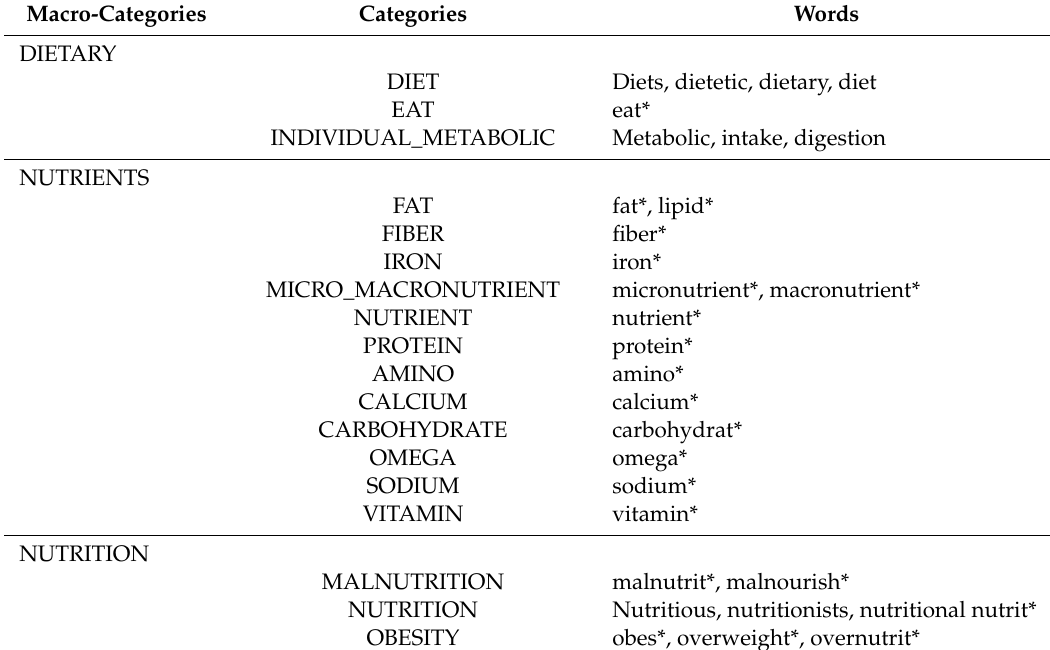
Table A2. Dictionary of Nutrition dimension: Macrocategories, categories, words.